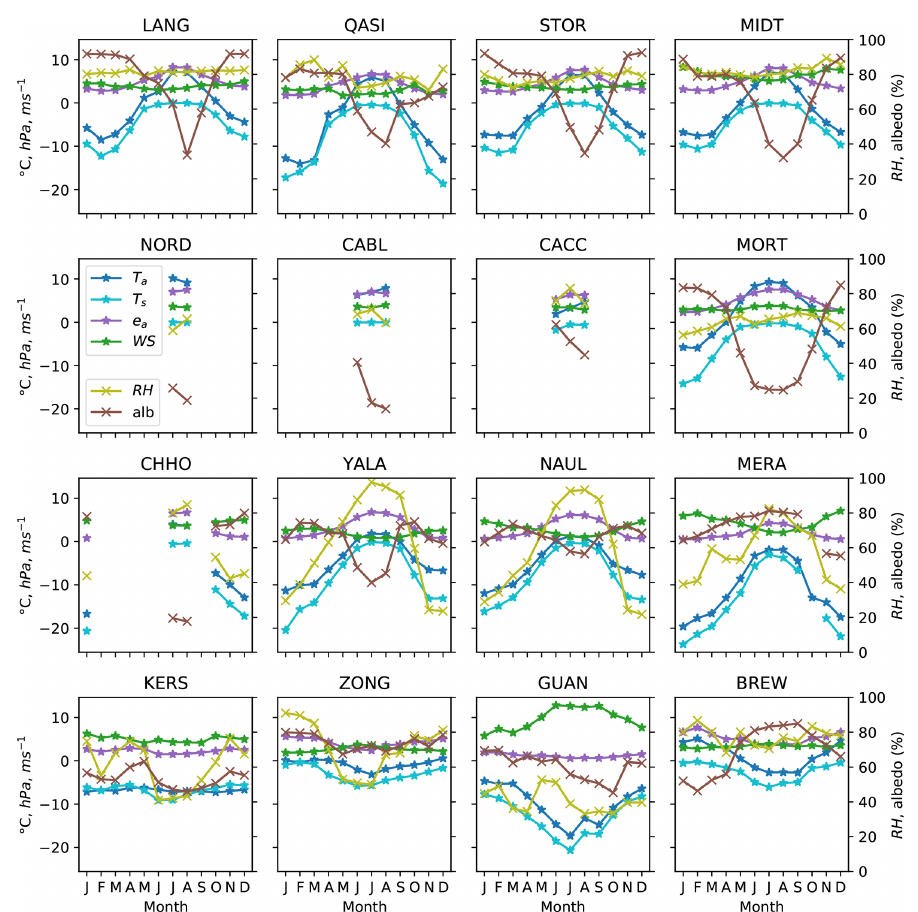
Figure A1. Monthly average near-surface meteorological conditions at each site. Note that the monthly value is only shown for a site if it has > 10 complete days in a month across the full